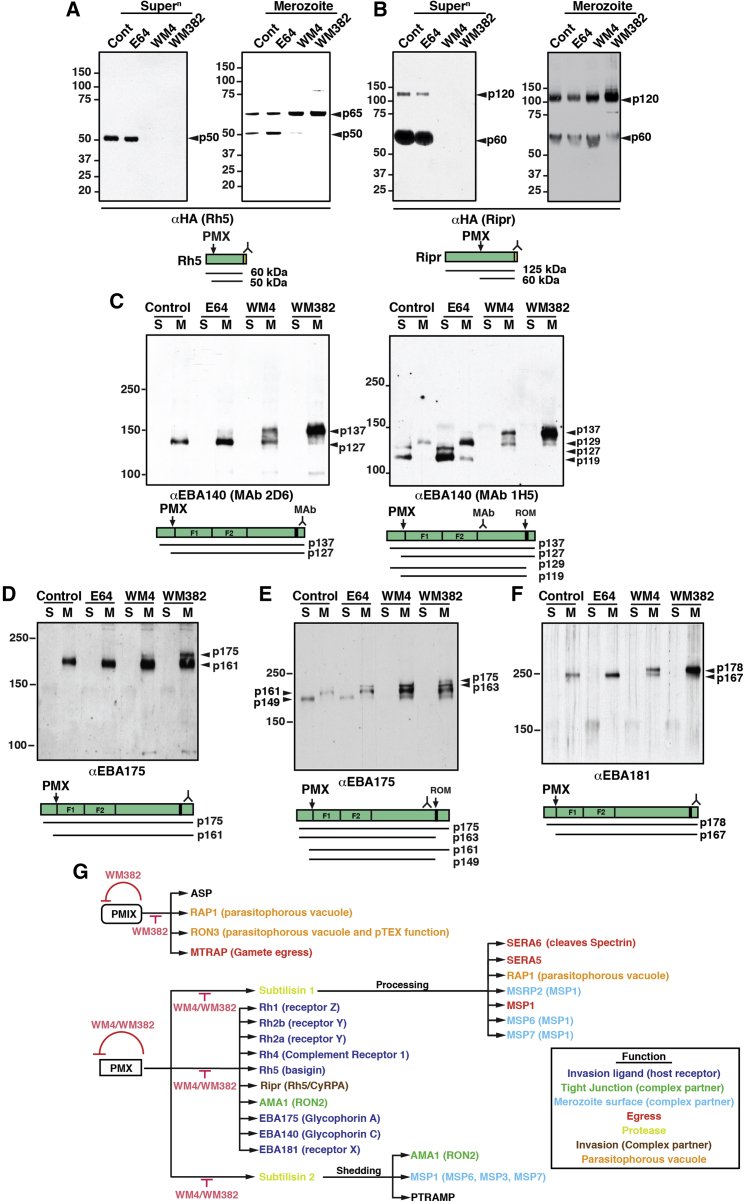
Rh5 Complex and EBA Proteins Processed by PMX or PMIX(A) Rh5 processed by PMX and inhibited by WM4 and WM382. Left: supernatant. Right: merozoites.(B) Ripr processed by PMX or PMIX inhibited by WM4 and WM382. Left: supernatant. Right: merozoites.(C) EBA140 processed by PMX and inhibited by WM4 and WM382. Left: αEBA140 monoclonal antibody (mAb) (2D6). Right: αEBA140 mAb (1H5).(D) EBA175 processed by PMX and inhibited by WM4 and WM382.(E) EBA175 processed by PMX and inhibited by WM4 and WM382.(F) EBA181 processed by PMX and inhibited by WM4 and WM382.(G) Summary of PMX function.A summary schematic for each protein is shown (HA-tag, yellow box; transmembrane, black box). Supernatants (Supern or S) released from merozoites. M, merozoites. Position of detecting antibody signified by . C–F schematics show positions of F1 and F2 receptor binding domains. Molecular weight kDa.